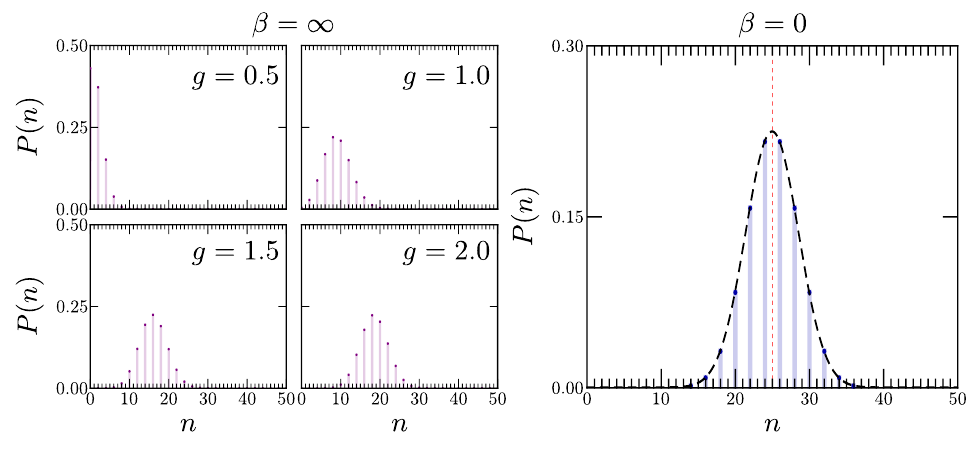
Figure 7: Limiting cases of kink number distribution. Probability distribution of the number of kinks P ( n ) as a function of the magnetic field g and inverse tempera- ture β for a chain of L = 50 spins. The left panel shows the kink-number distribution for different values of the magnetic field and is obtained using the ground-state char- acteristic function Eq. (93). The right panel shows the kink number distribution at infinity temperature, computed using the characterization function given by Eq. (94). = L / 2, while the long-dashed black line The vertical dashed red line is located at κ 1 corresponds to the Gaussian approximation N ( L / 2, L / 4 )